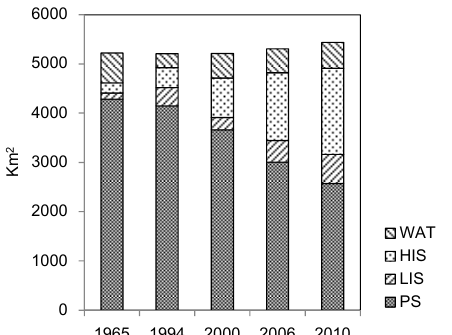
Figure 3. Change of four types of impervious and non-impervious surfaces in Shanghai (1965–2010). WAT = water, HIS = high impervious surfaces, LIS = low impervious surfaces, PS = pervious sur- faces.